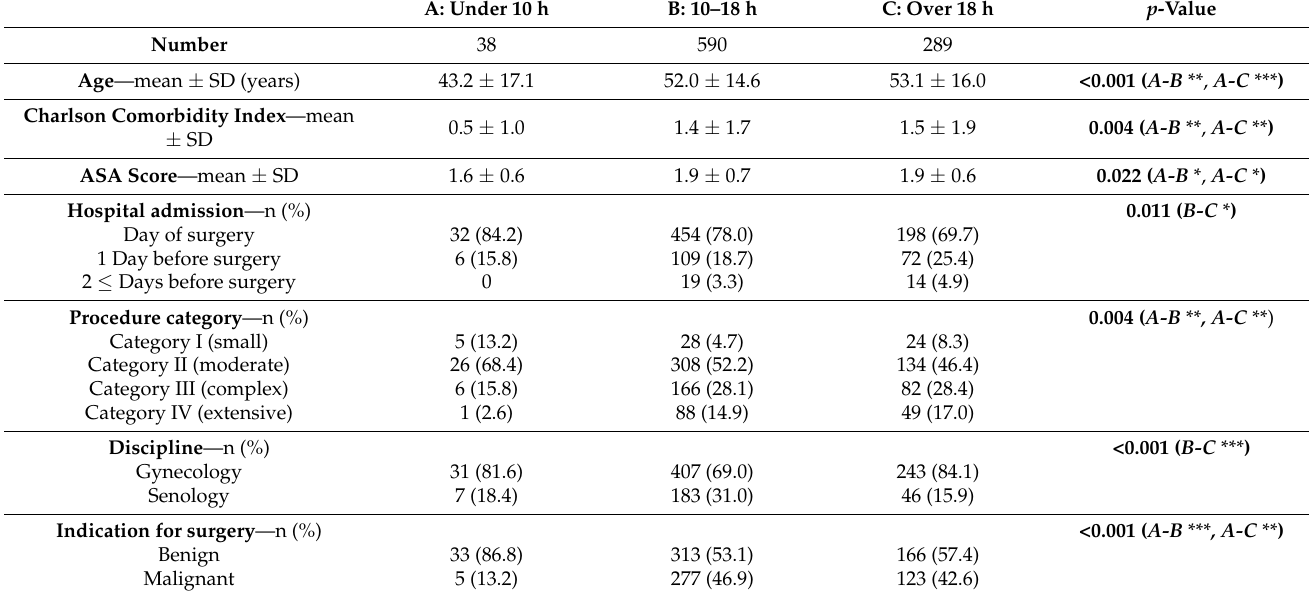
Table 3. Patient characteristics in relation to preoperative fasting categories for solid foods. A = Adequate fasting with a fasting interval of less than 10 h. B = Prolonged fasting with a fasting interval between 10 and 18 h. C = Extensively prolonged fasting with a fasting interval over 18 h. p -values are displayed for intergroup differences from ANOVA testing. Significance level with post hoc testing is indicated as follows: * p < 0.5, ** p < 0.01, *** p < 0.001. SD = standard deviation, n =